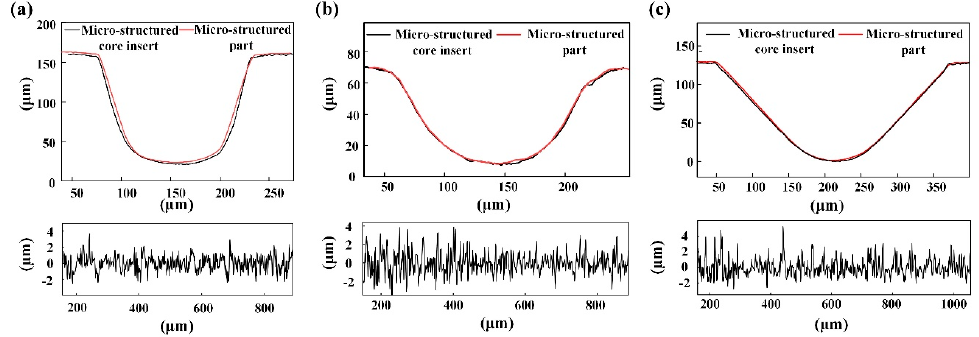
Figure 8. Cross-sectional profiles and roughness curves of the micro-structure: ( a ) U-shaped; ( b ) semi-circular; ( c ) V-shaped.